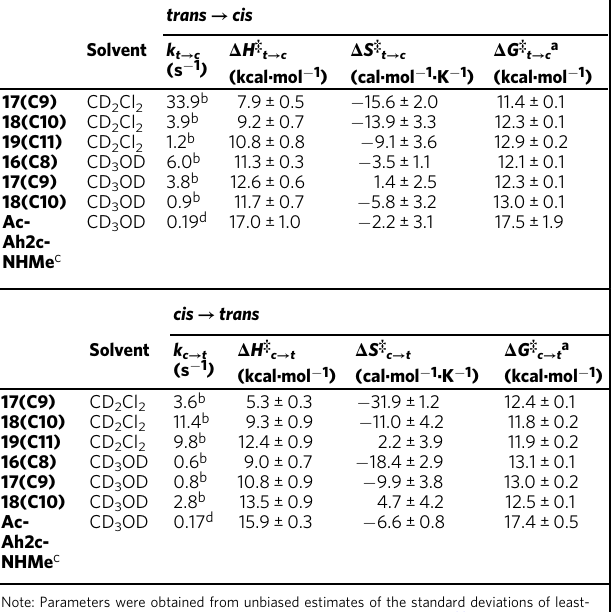
atoms in the ring, and there was a fl uctuation at 18(C10) : the cis forms: 16(C8) : 6.01 Å; 17(C9) : 6.21 Å; 18(C10) : 6.15 Å; 19(C11) : 6.34 Å) (Fig. 4b). From the observed cis/trans ratio (Table 1), a